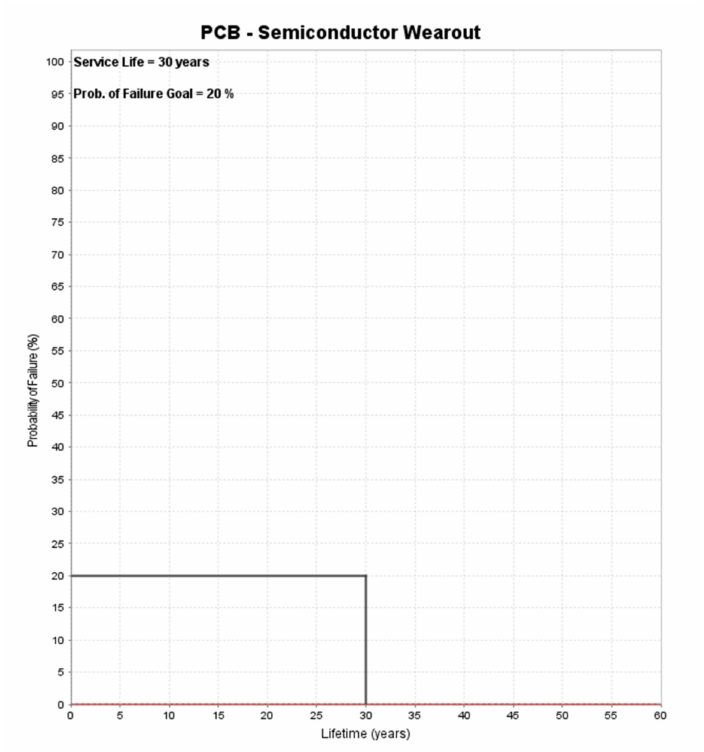
Figure 17. The wear-out of PCB semiconductor.